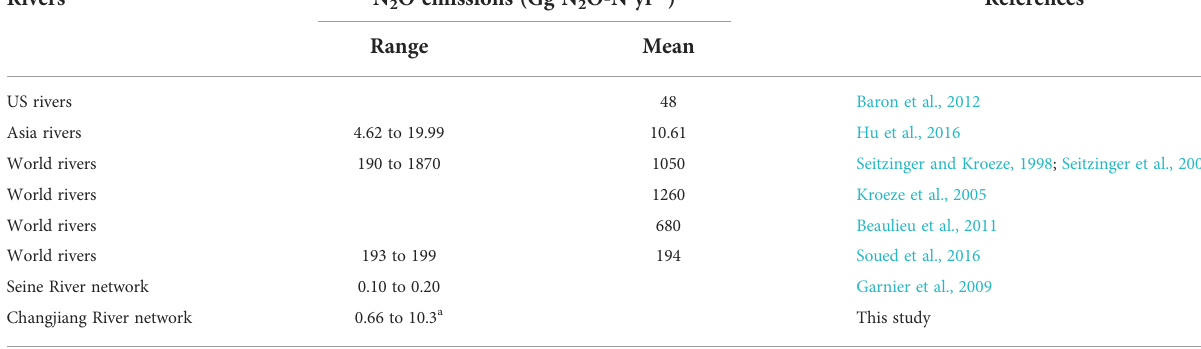
TABLE 2 N 2 O emissions from regional and world rivers.